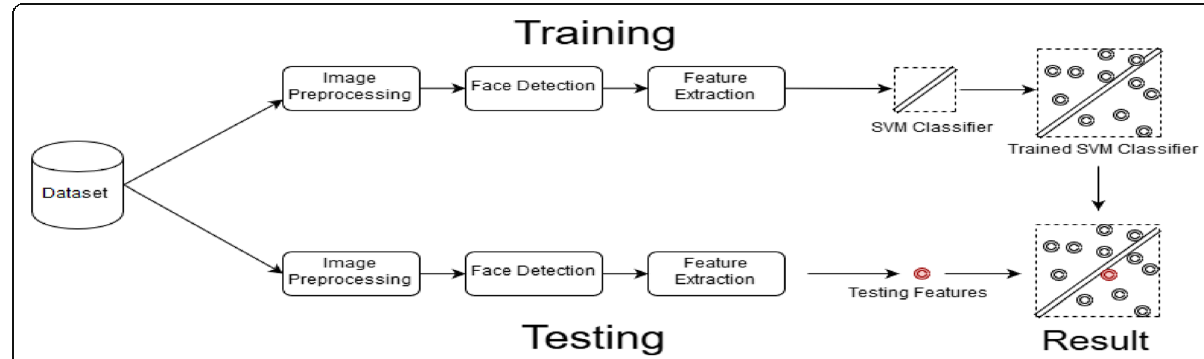
Fig. 1 General skeletal structure: dividing the dataset into training and testing sets